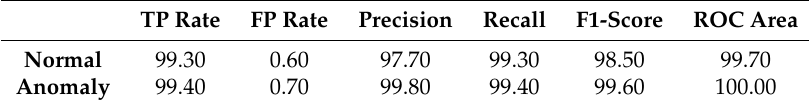
Table 18. Classification report for Bagging Random Forest.